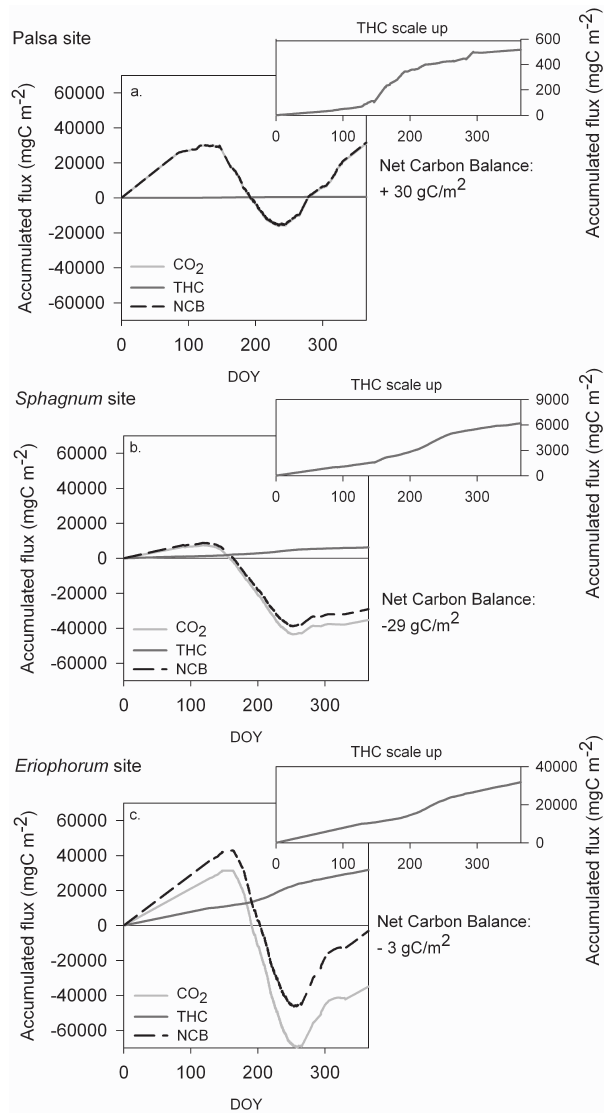
Fig. 4. Accumulated fluxes of CO 2 , THC and NCB where each site is presented separately. Positive numbers represent addition to the atmosphere and negative numbers represent loss from the atmo- sphere. DOY on the x axes stands for day of year. All fluxes in mgCm − 2 .